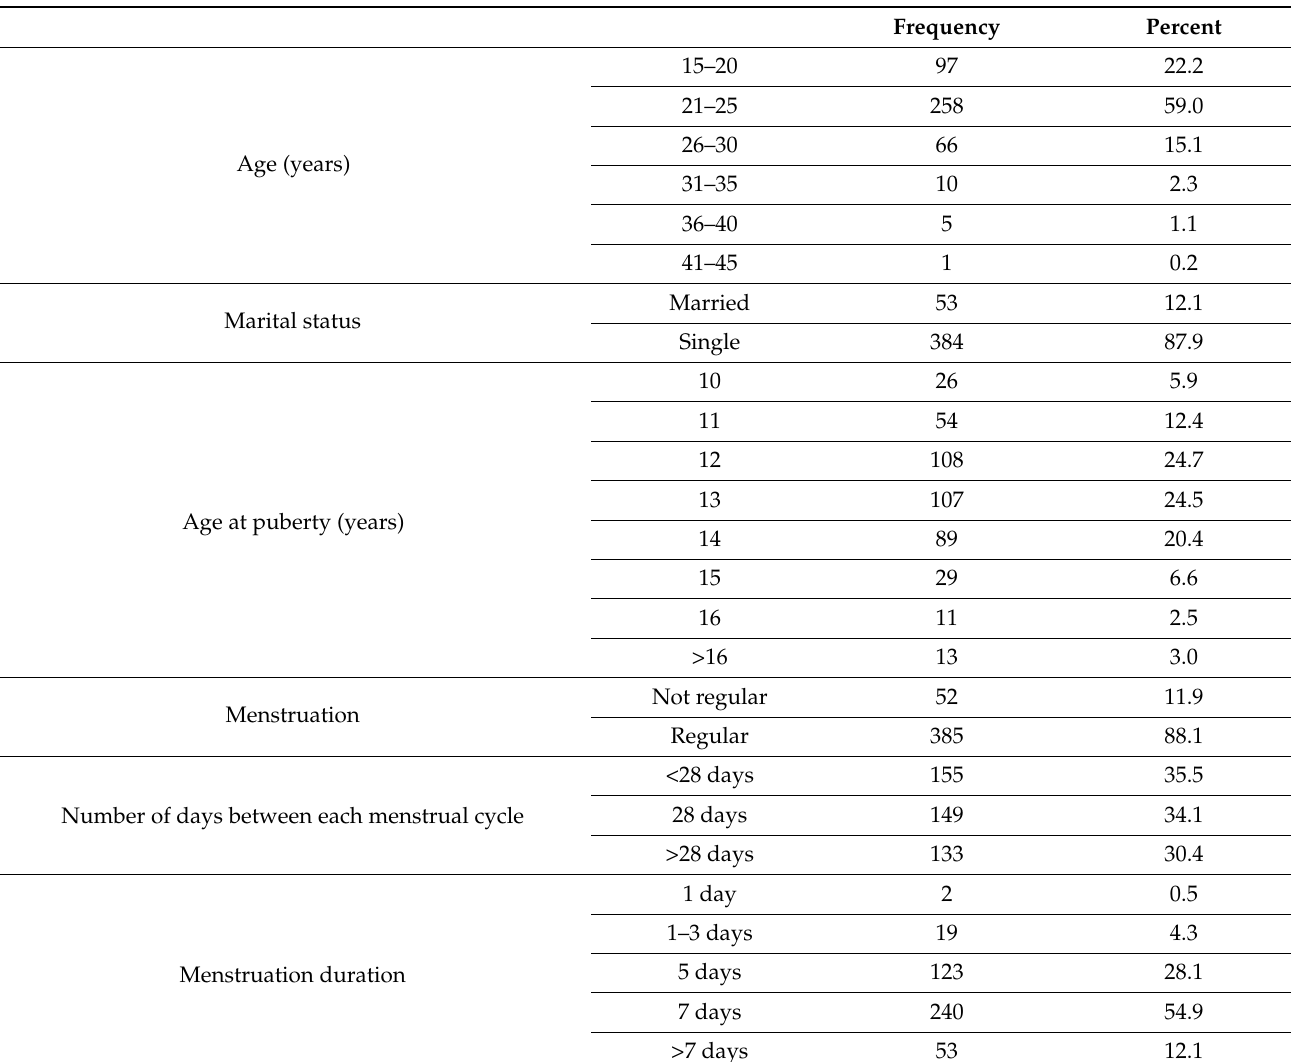
Table 1. Baseline